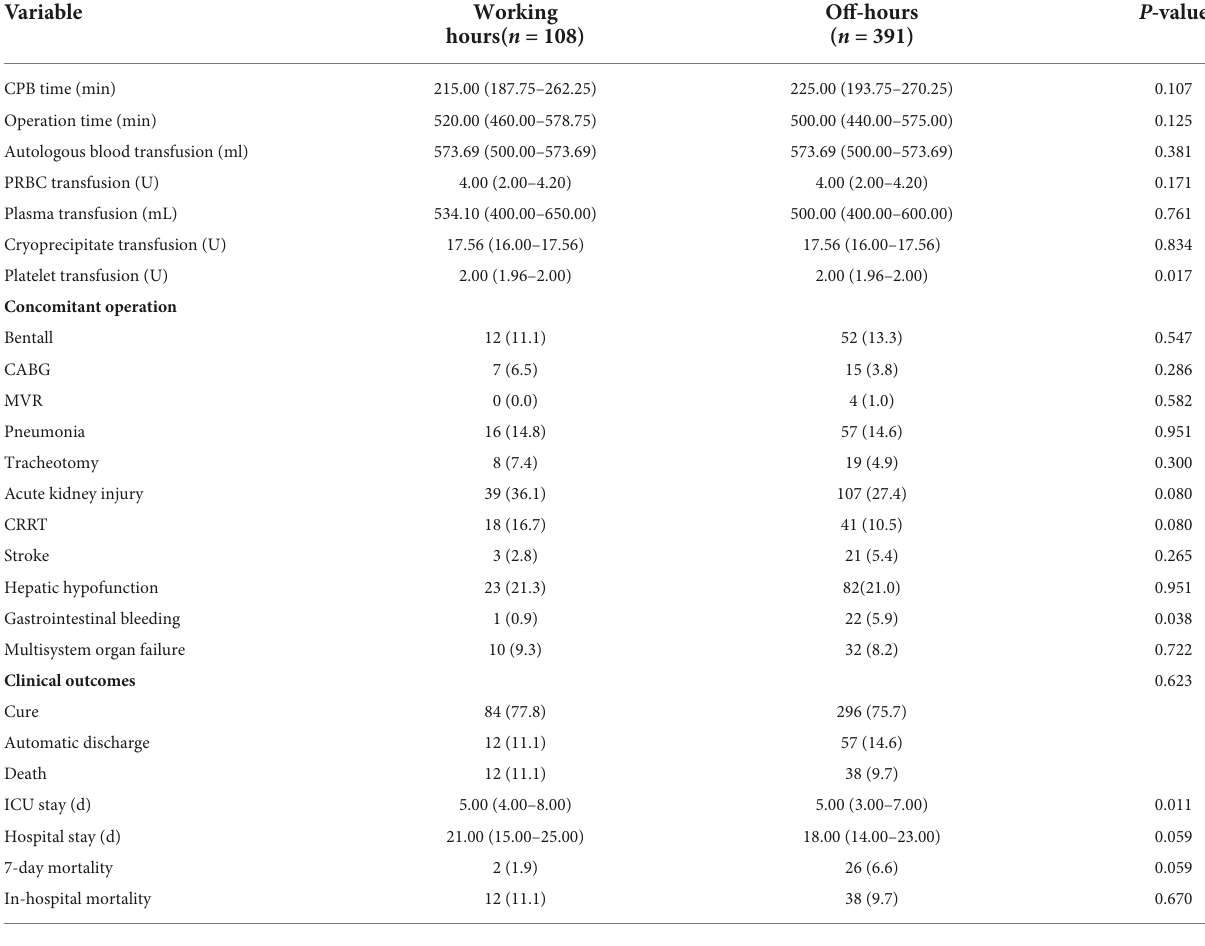
TABLE 5 Intraoperative and postoperative characteristics of working hours and off- hours groups.